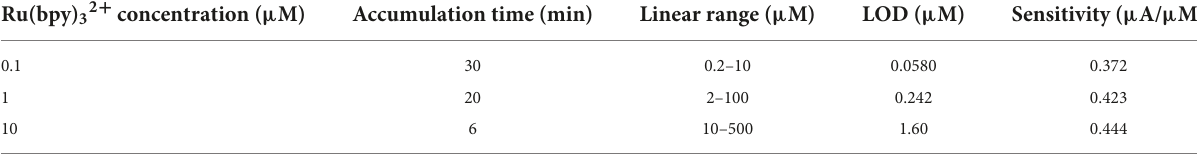
TABLE 1 Comparison of G detection performance with different mediator contents.